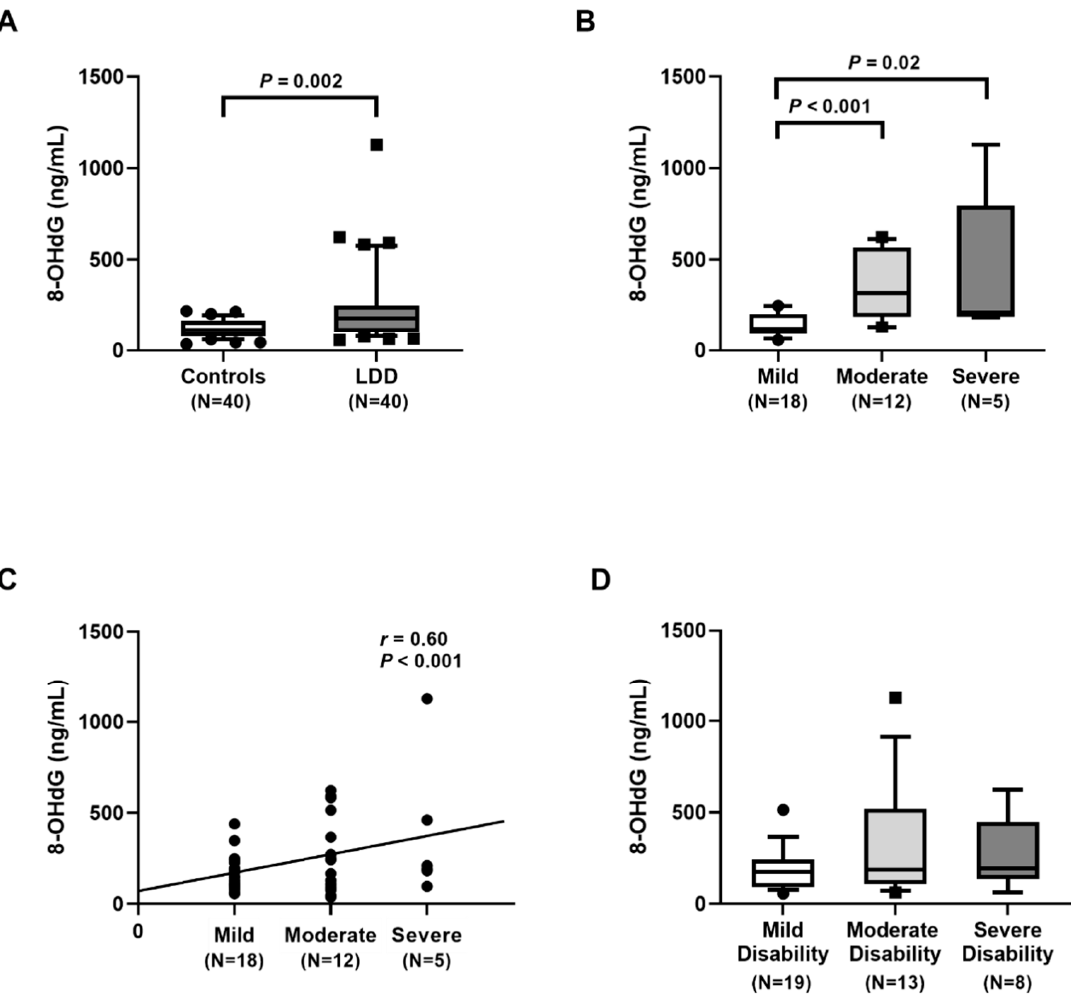
Figure 3. Determination of 8-hydroxy-2 (cid:48) -deoxyguanosine (8-OHdG) concentration: ( A ) comparison of 8-OHdG concentration in lumbar disc degeneration (LDD) patients and controls. Circles represent control group, squares LDD group; ( B ) comparison of 8-OHdG concentration in LDD, based on the disease severity. Circles represent mild group, squares moderate group; ( C ) correlation of 8-OHdG concentration and the radiographic severity. Circles represent individual data points; ( D ) comparison of 8-OHdG concentration in LDD, stratified by Oswestry disability index score. Circles represent mild group, squares moderate group.